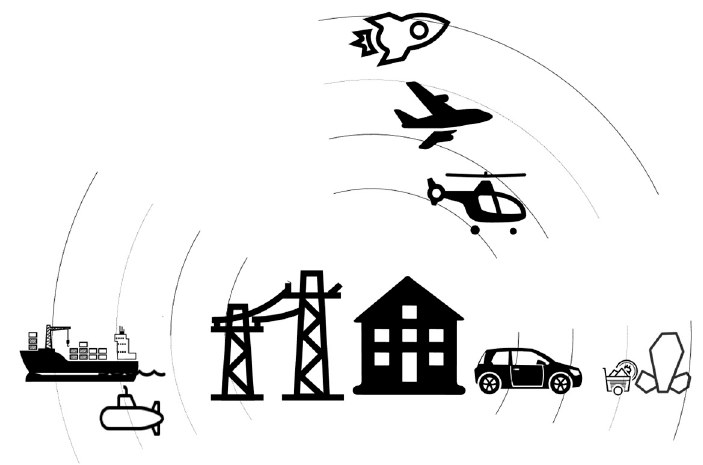
Figure 12. Schematic diagram of engineering application.